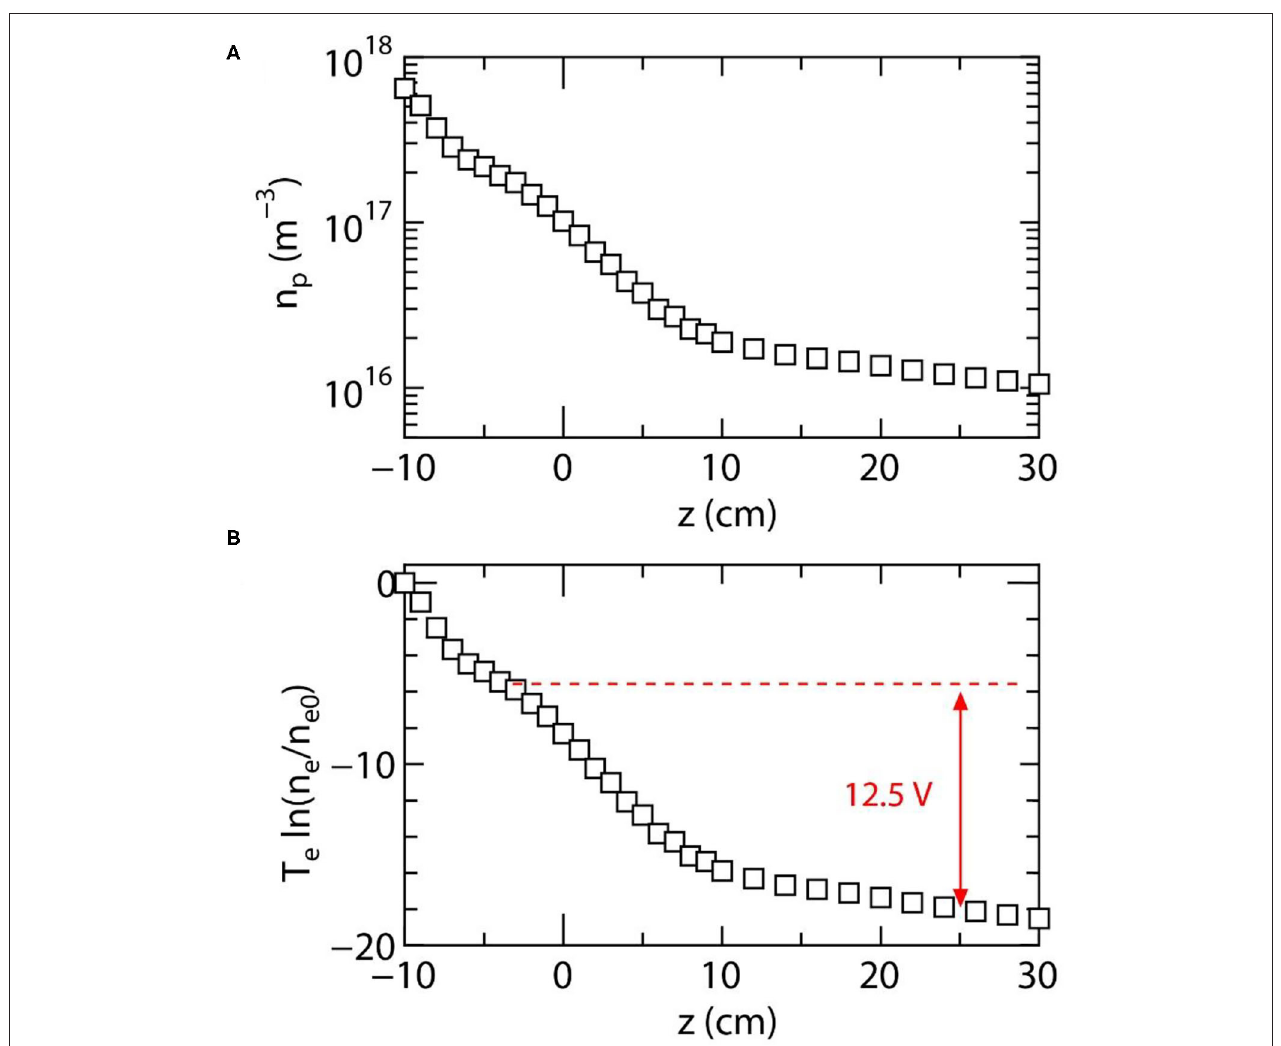
FIGURE 8 | (A) Axial profile of the measured plasma density n p on the z axis for P net = 500W and C Ar = 70 sccm. (B) Voltage V from the reference position ( z = − 10cm) calculated from the Boltzmann relation assuming a uniform electron temperature, where the measured temperature of T The dashed line and the arrow indicate the potential difference corresponding to the beam energy of ε beam ∼ 12.5eV [seen in Figure 7a ], implying that the beam ions are accelerated from the source